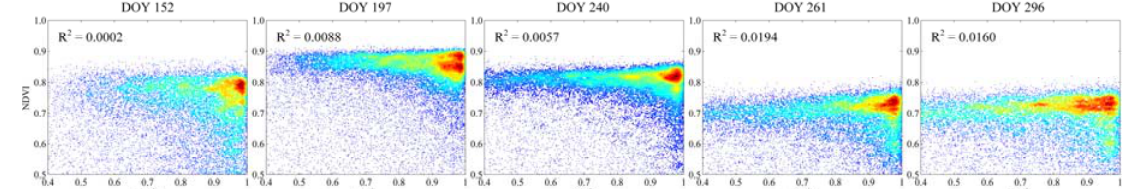
Figure 6. Density scatterplots between the NDVI and the cosine of the local solar incidence angle (cos( i )) in Wanglang study area for the different acquisition dates.